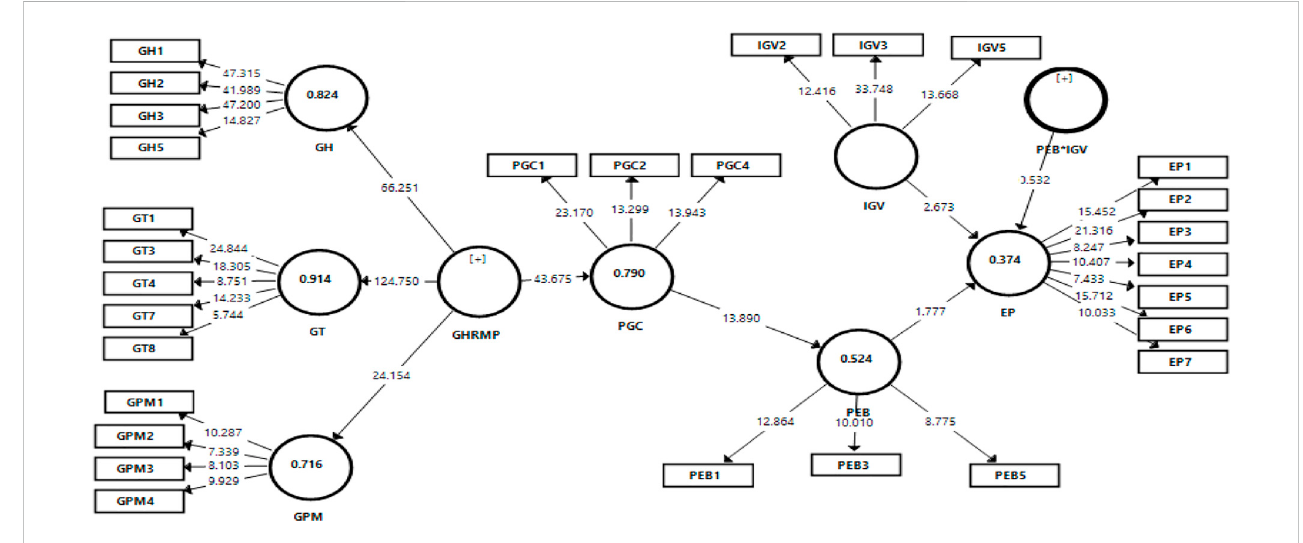
FIGURE 3 Structural model.